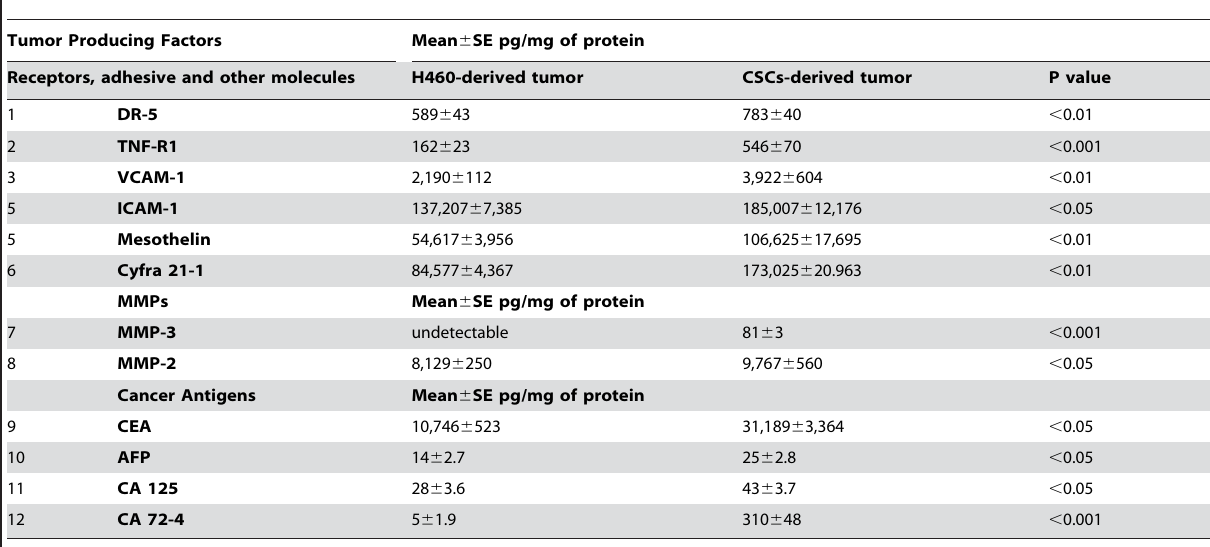
Table 3. Multiplex analysis of adhesive molecules, MMPs and cancer antigens in the lysates of xenografted parental H460 and CSC-derived tumors.